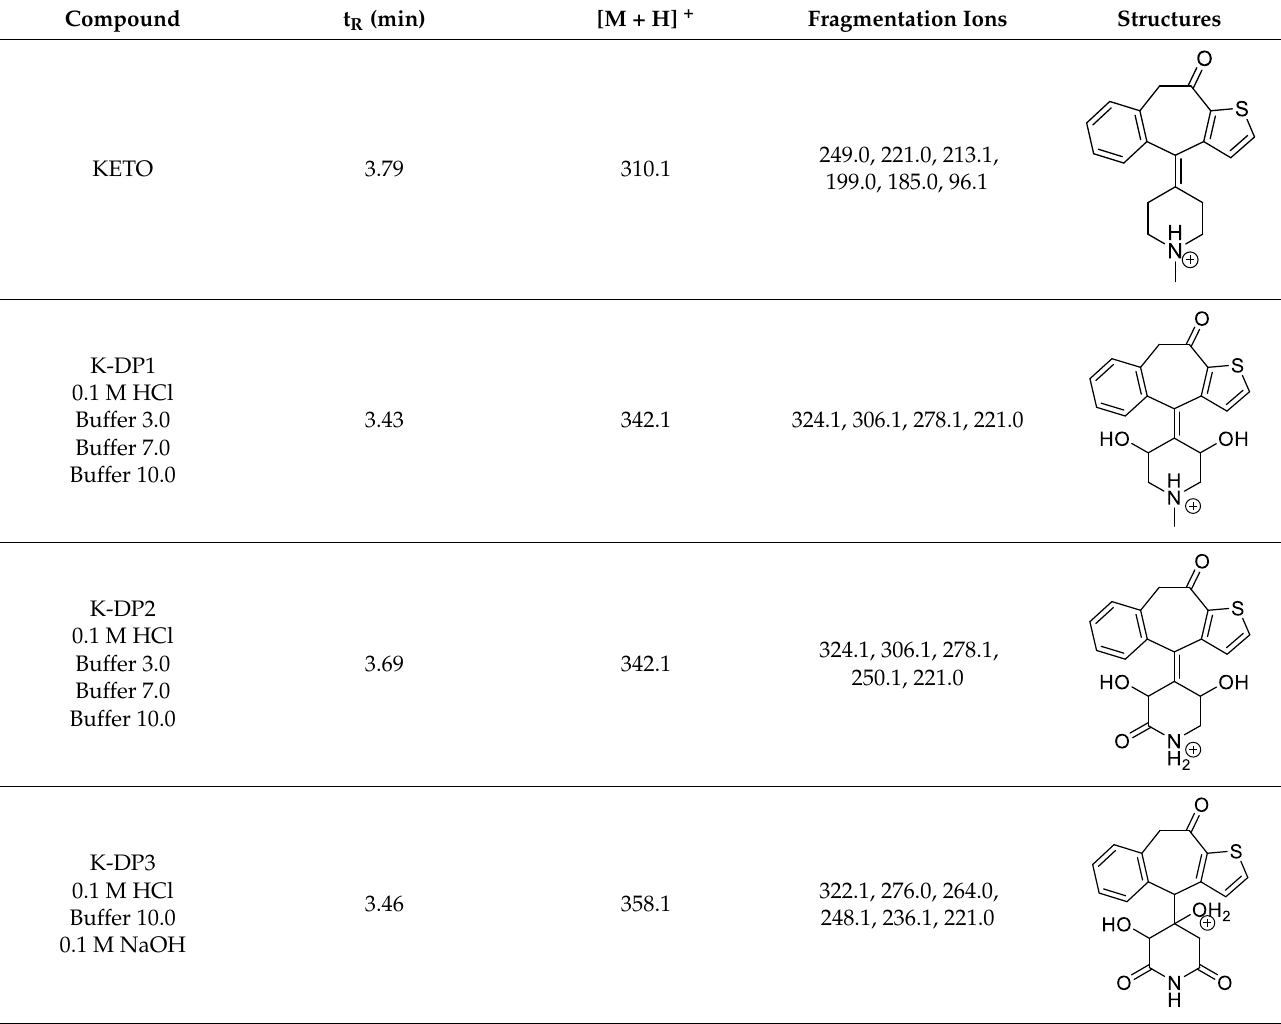
Table 3. MS/MS results for ketotifen (KETO) and its degradation products (K-DPs) at 70 °C. Compound Structures